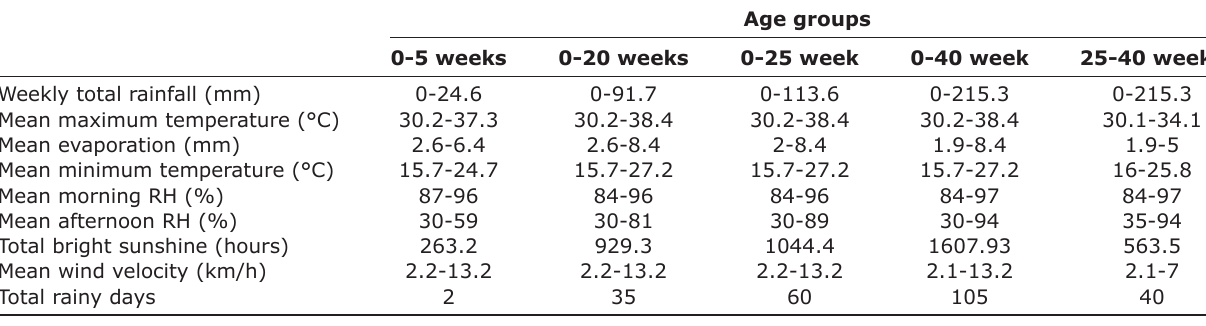
Table-1: Weekly values (ranges) of climatic variables at different ages of the poultry